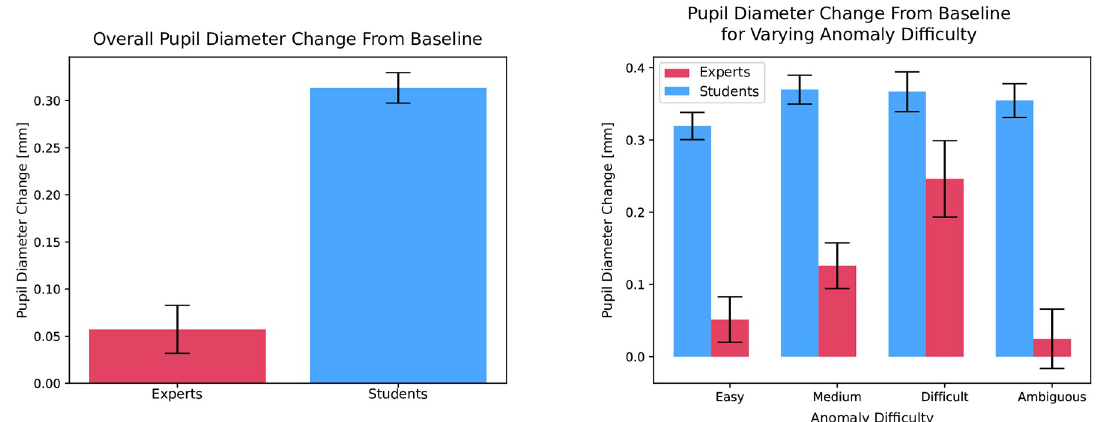
Fig 5. Pupillary response of experts and novices during visual Inspection. ( a ) Median Pupil Change From Baseline for Experts and Novices. ( b ) Median Pupil Change From Baseline for Gaze on Anomalies. The median pupil diameter change from baseline for students (blue bars) and experts (red bars) for the overall image behavior (5a) and when gazing on anomalies of varying difficulty (5b). Standard errors are indicated in black. Students had larger pupillary response from baseline compared to experts, but this effect was homogeneous for the differing anomalies. Whereas experts showed an increased pupillary response behavior as an effect of increasing difficulty.